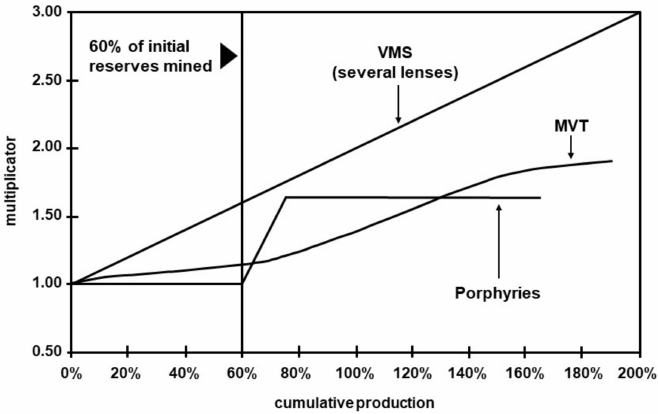
Figure 14. Development of reserves growth over time for porphyry copper deposits, Mississippi Valley-type led-zinc deposits (MVT), and volcanogenic base metal deposits (VMS) (translated from Wagner, 1999